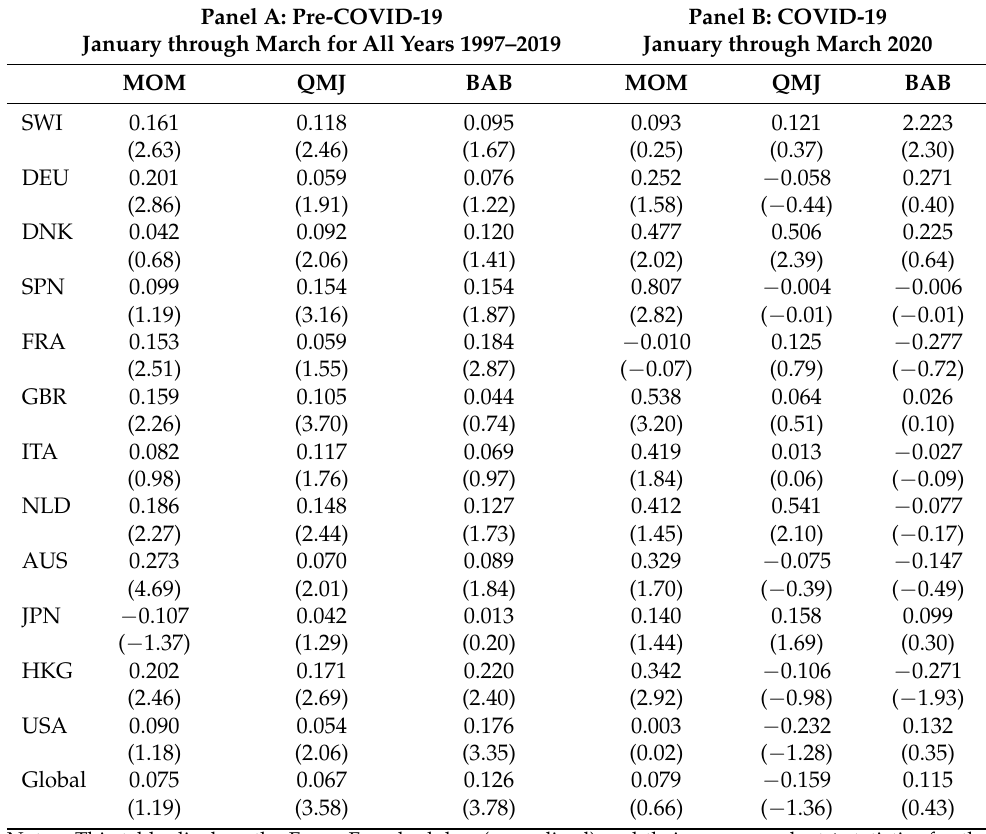
Table 5. Annualized Fama–French Alphas. Panel A: Pre-COVID-19 Panel B: